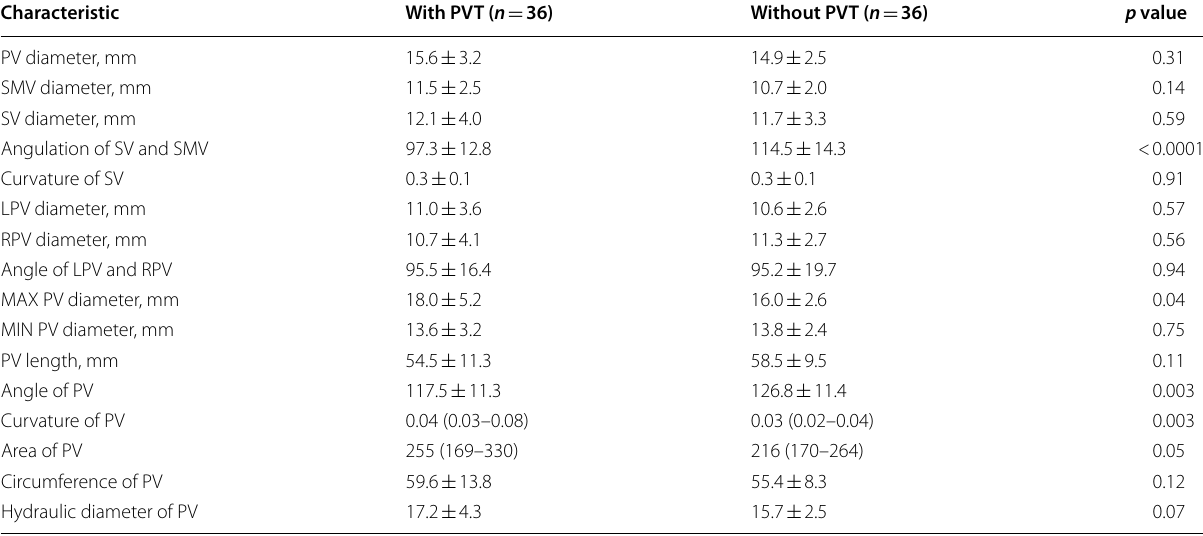
PV, portal vein; SMV, superior mesenteric vein; SV, splenic vein; LPV, left portal vein; RPV, right portal vein; MAX, maximum; MIN, minimum